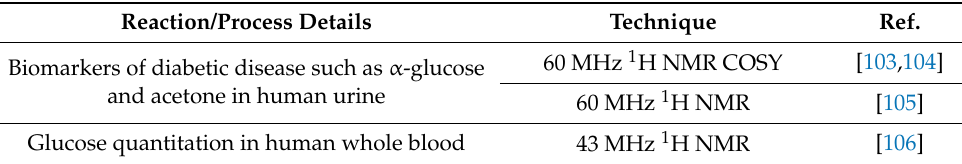
Table 6. Applications of benchtop NMR spectroscopy to disease monitoring.